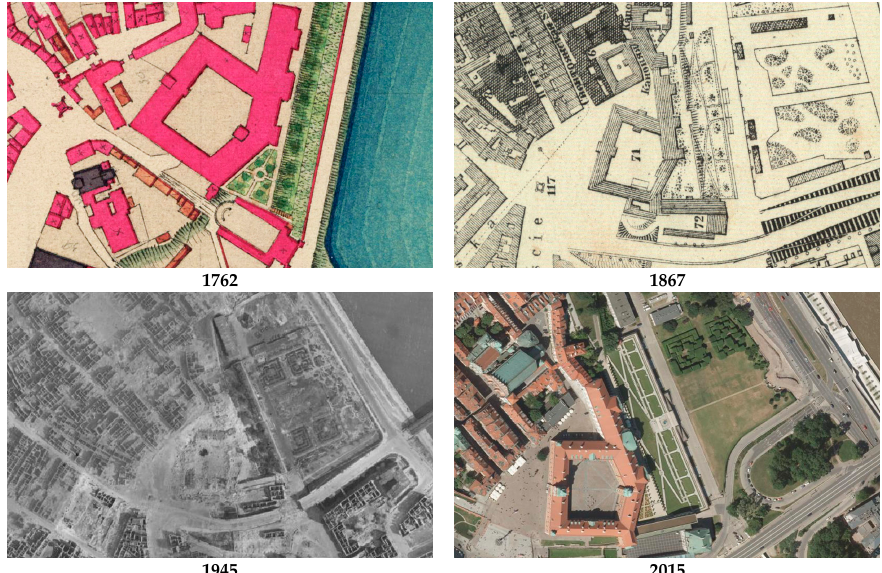
Figure 2. The Royal Castle in Warsaw presented on the historical maps from 1762, 1867, an aerial image from 1945, and an orthophotomap from 2015 (map images distributed by the National Library in Poland under a public domain license; an aerial image and an orthophotomap distributed by the Office of Surveying and Cadastre of Warsaw as public